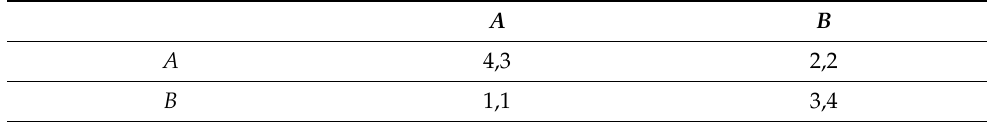
Table 4. Agents’ output with no Nash